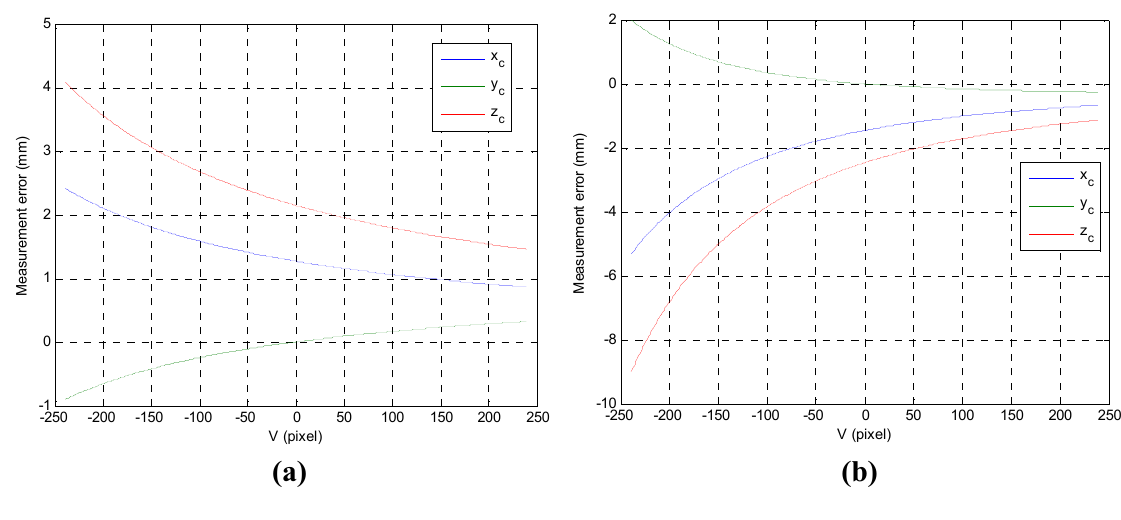
Figure 6 . Measurement errors of the LVS with 1% inexact value of ( a ) the baseline and ( b ) the projection